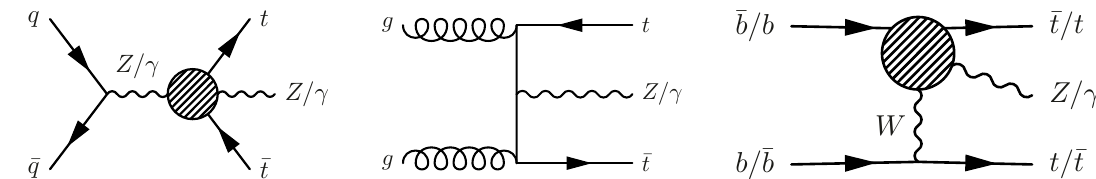
Figure 24. Left : schematic Feynman diagram for the EW-induced t (cid:22) t ( Z=(cid:13) ) process and its em- bedding of the t Z t Z , t Z t (cid:13) or t (cid:13) t (cid:13) subamplitudes. Middle : sample Feynman diagram ! ! ! for QCD-induced t (cid:22) t ( Z=(cid:13) ), which does not embed the 2 2 scatterings. Right : sample Feynman ! diagram for the b (cid:22) b -induced t (cid:22) t ( Z=(cid:13) ), which embeds the single top 2 2 !